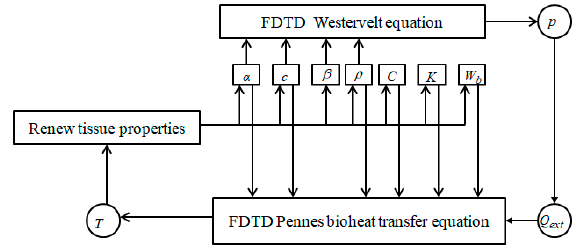
Figure 3. Flowchart of the iterative method for coupling acoustic pressure and temperature calculation.